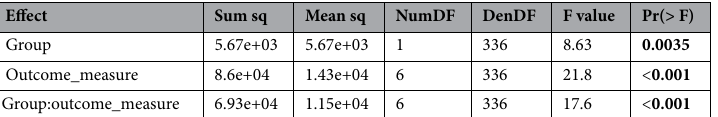
Table 4. Split Magnitude of Plateau ANOVA: results of the mixed model for the magnitude of asymmetry of the gait parameters at the point at which plateau occurred for the split [lmer Eq. (2)]. Bolded p-values indicate significance of the corresponding factor. The group factor refers to the younger and older adult categories and the outcome measure factor refers to the different gait